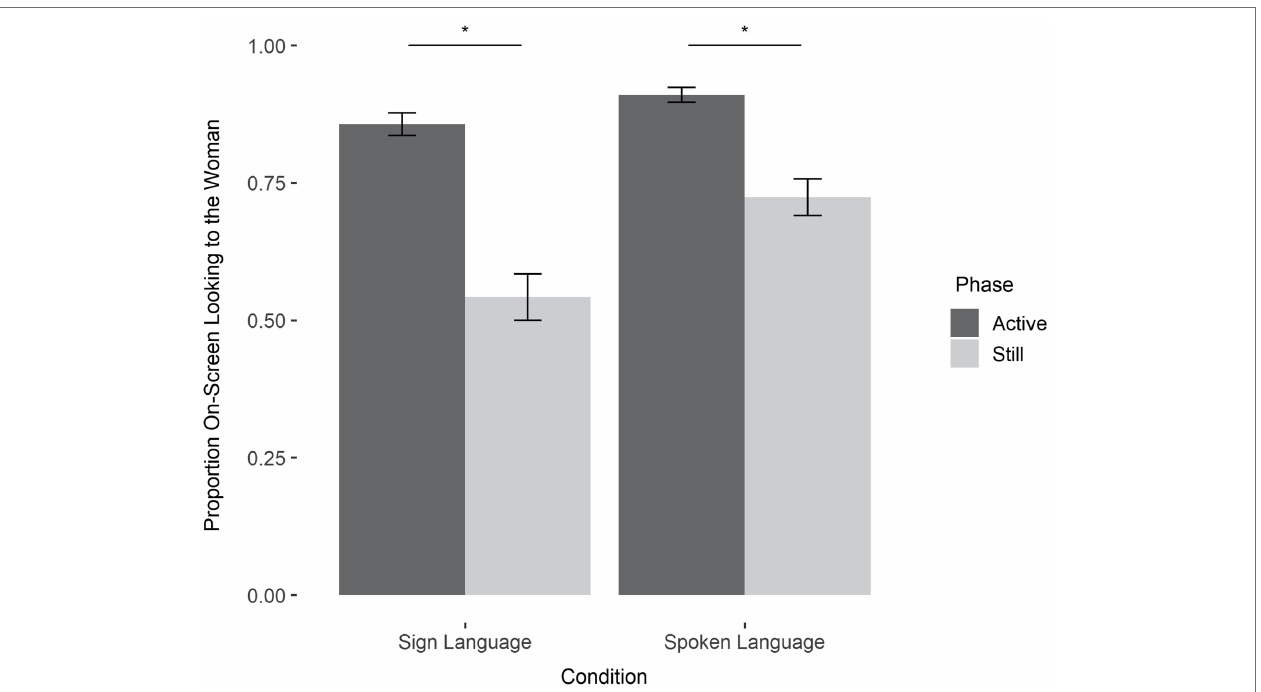
FIGURE 2 | Proportion of on-screen looking to the woman (as compared to the object) by condition and phase. Across both conditions, infants looked at the woman more during the active phase than the still phase (sign: M active = 85% SD active = 10%, M still = 54%, SD active = 20%, t (22) = 9.08, p < 0.001; spoken: M active = 91% SD active = 6%, M still = 72%, SD active = 16%, t (21) = 6.53, p < 0.001). This difference between active and still was greater for the sign language condition than the spoken language condition (interaction: p <